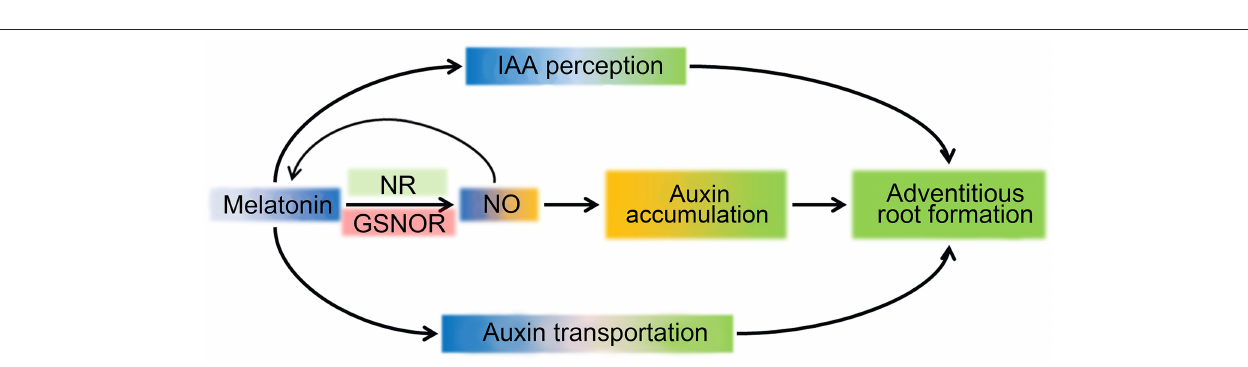
FIGURE 8 | Schematic illustration for MT signaling induced ARF. MT triggers NO accumulation by up-regulating expression of NR and down-regulating GSNOR . In turn, NO feedback controls the accumulation of MT. The accumulation of auxin could be induced by NO to improve the ARF process. In parallel, perception and transport of the auxin signal are also present, leading to ARF in the MT signaling pathway.